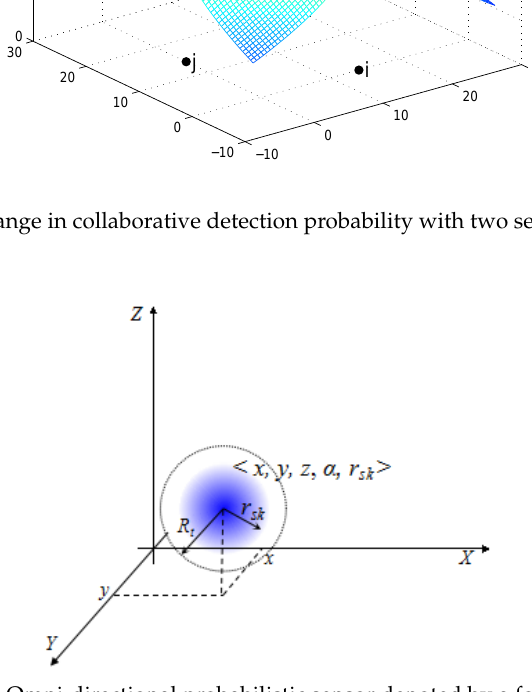
Figure 3. Omni-directional probabilistic sensor denoted by a